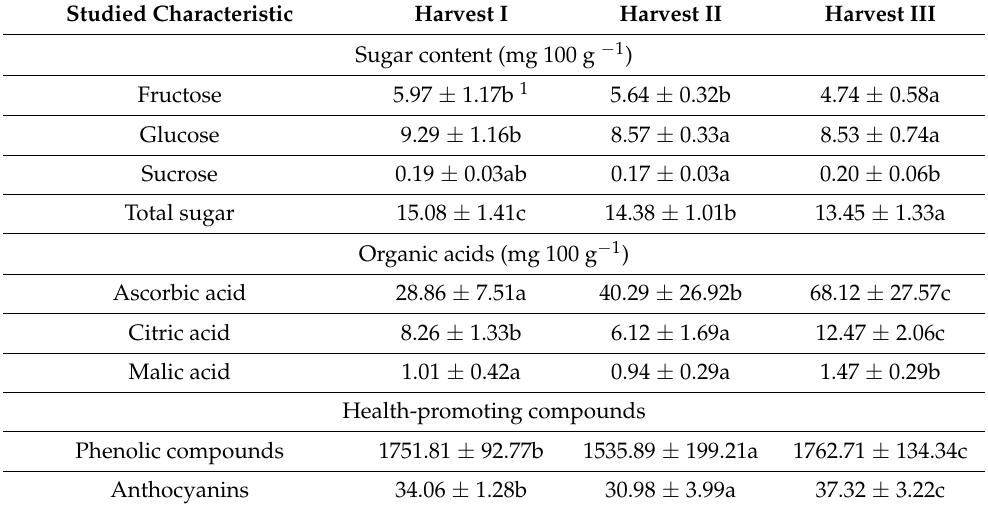
Table 13. Impact of harvest time on the content of sugar, organic acids, and health-promoting compounds in blueberry fruit (harvest I—end of July; harvest II—beginning of August; harvest III—mid-August). Studied